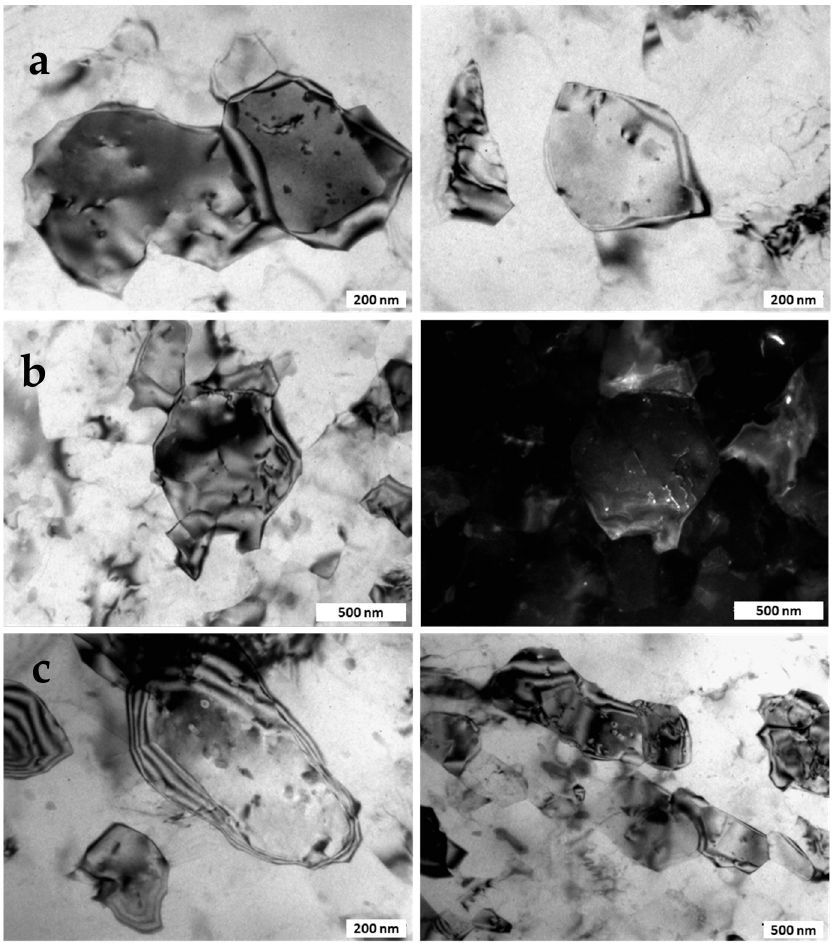
Figure 7. TEM bright field images of the UFG structure revealing precipitates and dislocations after SP deformation at: ( a ) 120 °C; ( b ) 150 °C and ( c ) 180 ° С . (111) pole figures calculated from by EBSD orientation data represent local texture